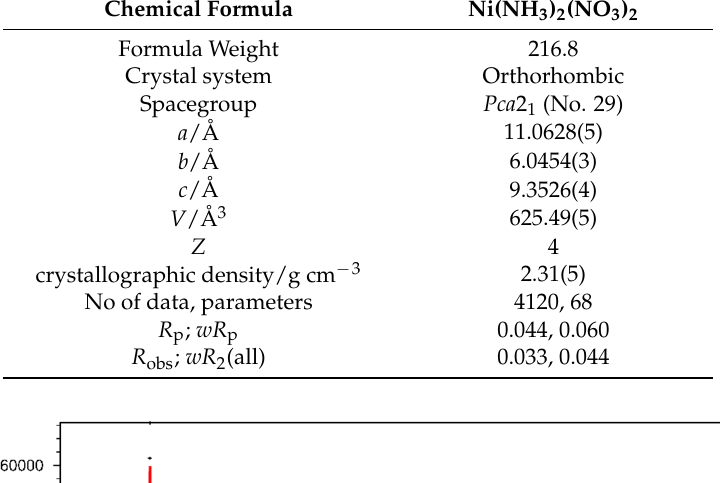
Table 2. Refinement details for Ni(NH 3 ) 2 (NO 3 ) 2 .